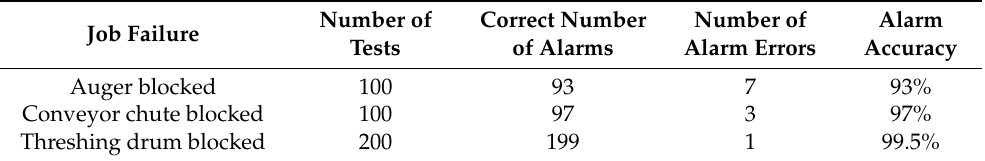
Table 4. Combine harvester failure alarm